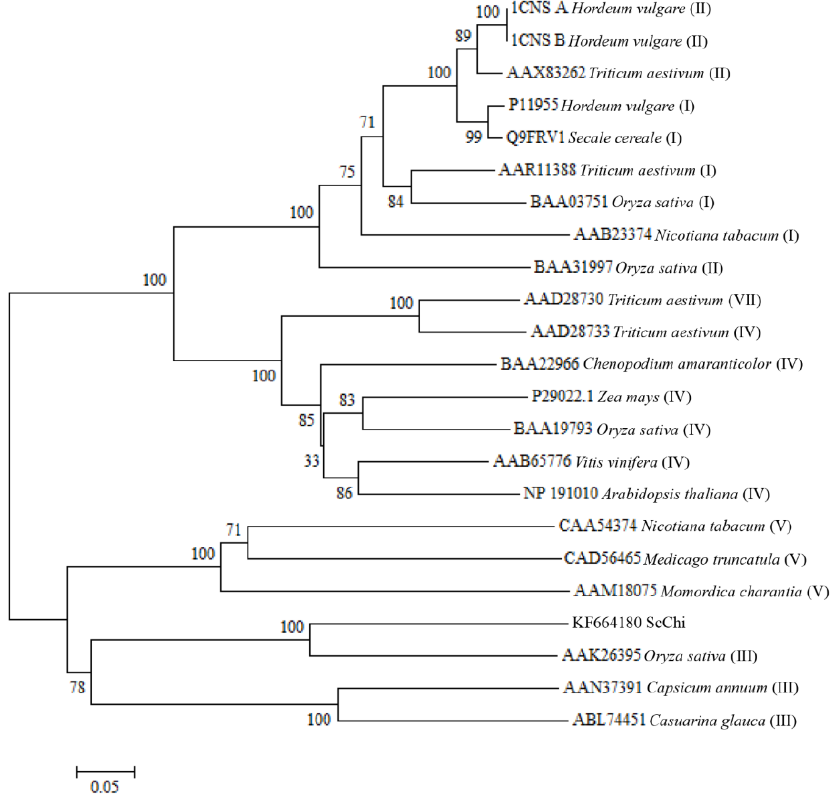
Figure 2. Nucleotide acid sequences obtained by real-time (RT)-PCR and the deduced amino acid sequences of ScChi . The deduced amino acid sequences are shown as a one-letter code under the cDNA sequences. The underline indicates the catalytic domains (DXXDXDXXXE) of the glycosyl hydrolase family 18. The eight red squares of